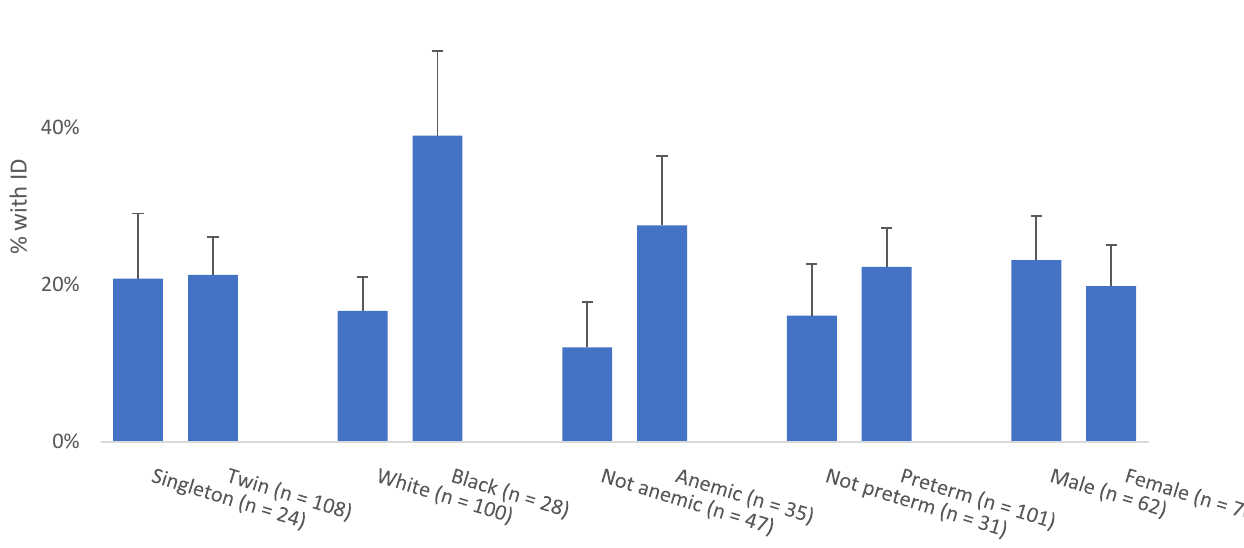
Figure 1. Prevalence of ID by selected maternal and infant characteristics. Bar height indicates the prevalence of ID within each level of the characteristic. Error bars indicate the standard error of the estimated prevalence. Prevalence and standard errors were estimated with mixed effect linear re- gression models with a random effect for twin pair. Prevalence differences did not reach statistical significance in mixed effects models. ID, iron deficiency.